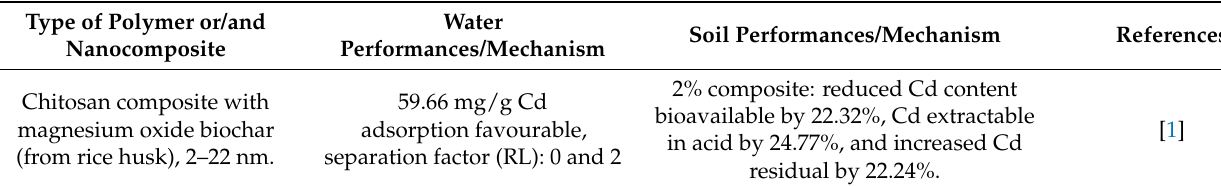
Table 1. Chitosan and its nanocomposites with double functionality for water–soil system